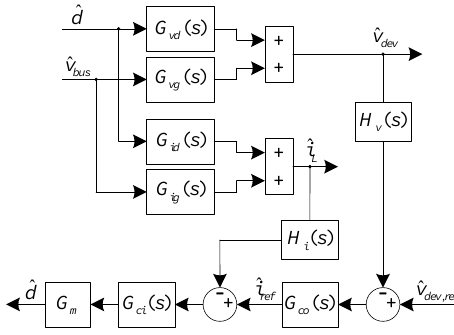
Figure 5. The small-signal control block diagram of a device-regulating converter.